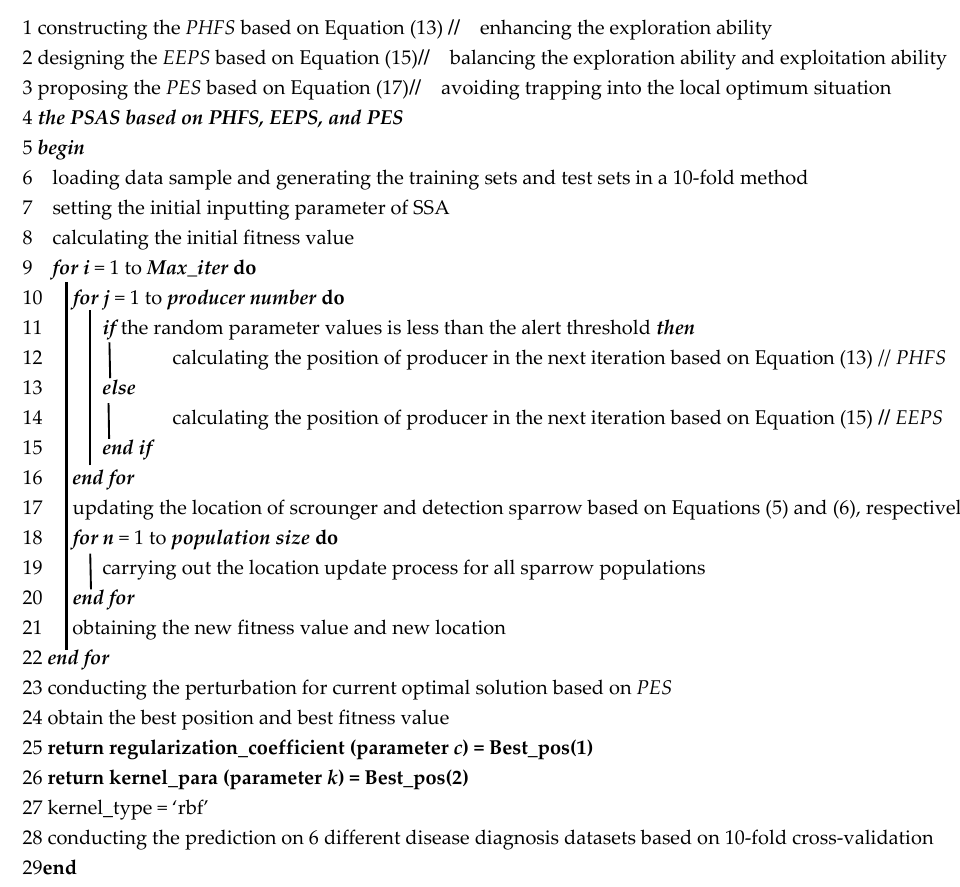
Table 2. The parameter values of different